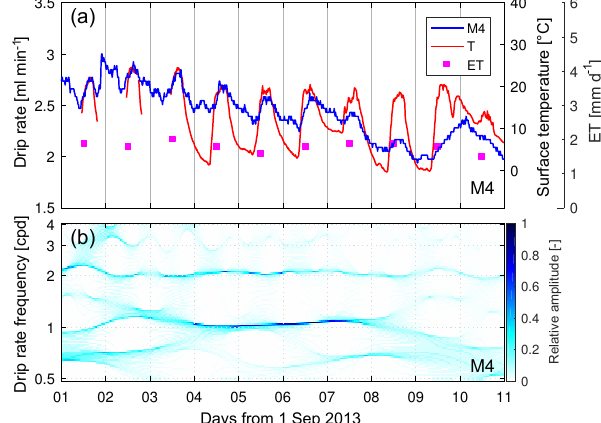
Figure 5. The raw drip discharge data, evapotranspiration, surface temperature and wavelet synchrosqueezed transform (WSST) plot of the drip discharge for site M4 from 1 to 11 September